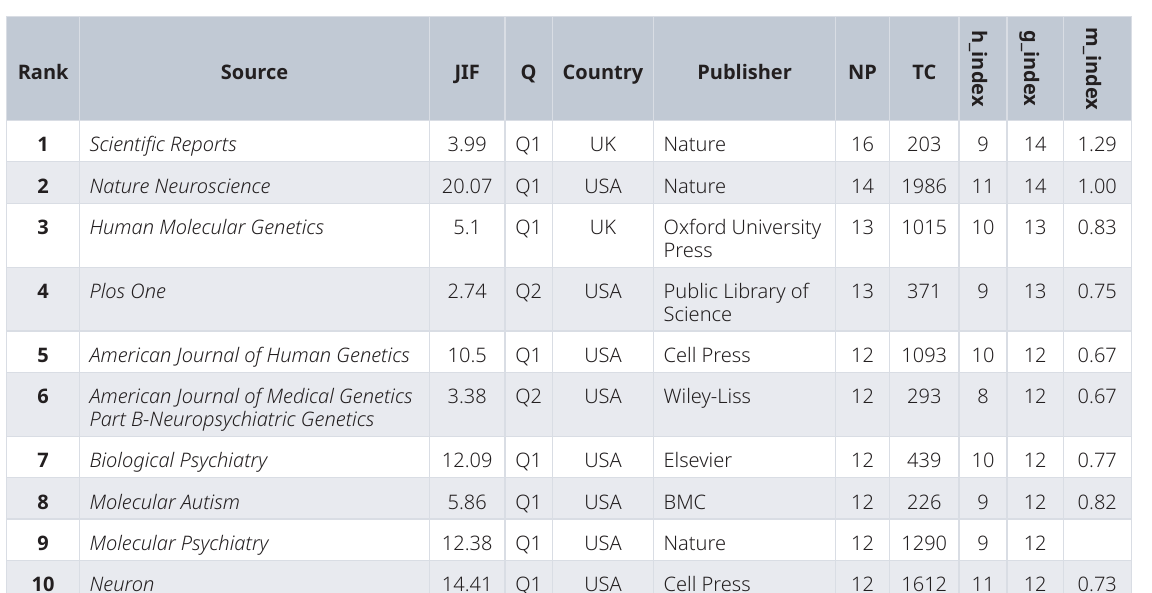
Table 5. Top ten appropriate sources in autism.